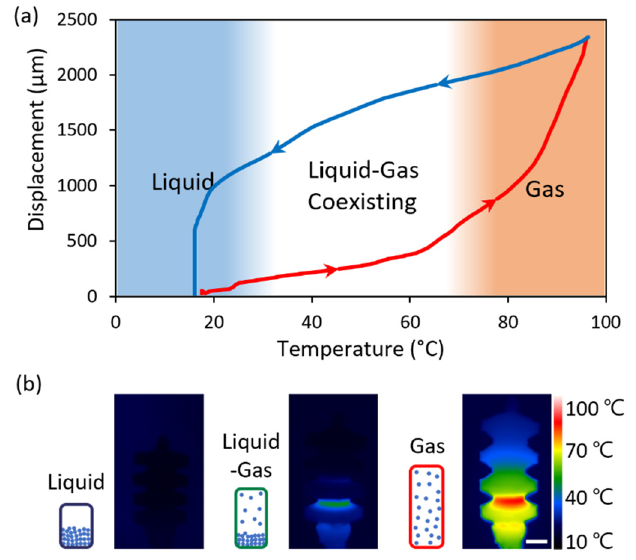
Figure 7. Response of the bellows actuator by the liquid–gas phase change: ( a ) Displacement according to the bellows surface temperature. The displacement increases along the red curve during heating and decreases along the blue curve during cooling owing to the powering off. ( b ) IR images of the actuator at each liquid–gas phase stage. The scale bar indicates 1 mm.